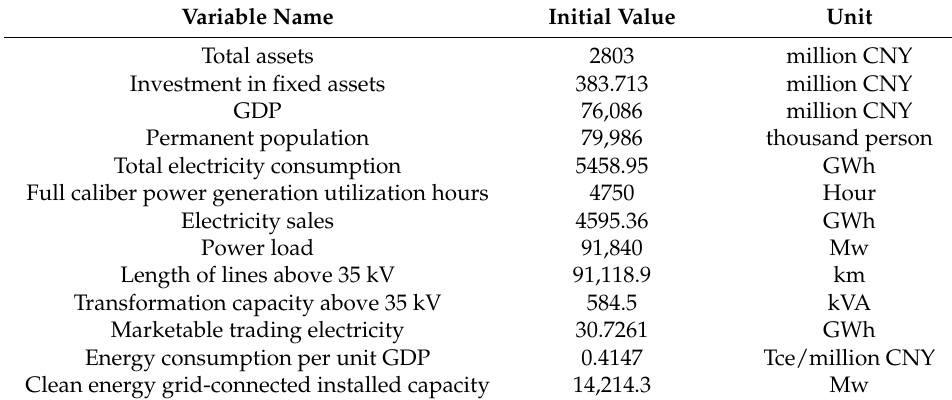
Table 1. Initial value setting of model variables.